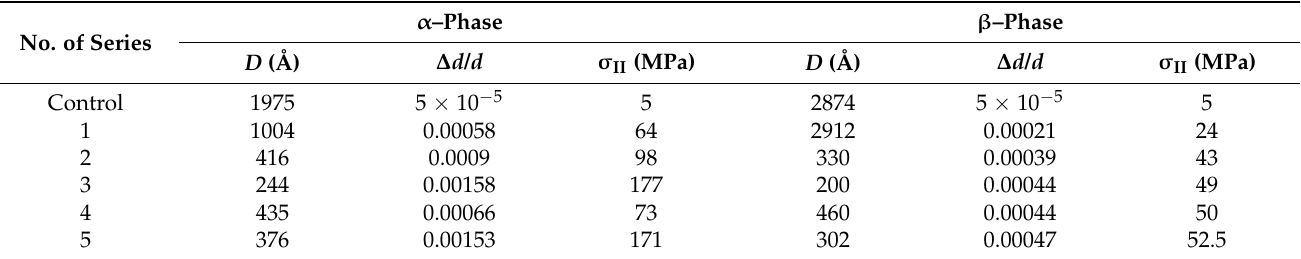
Table 3. The sizes of coherent scattering regions and values of microdistortions of the α - and β -phases in the investigated samples.